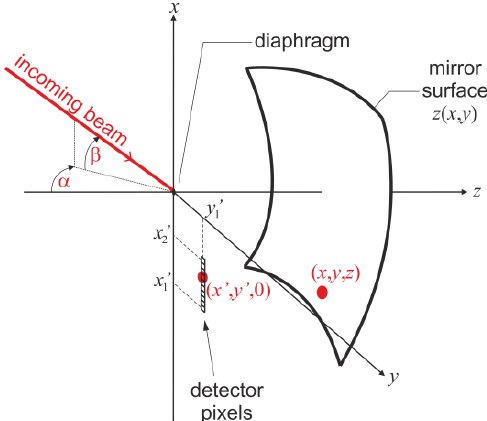
Figure 8. Geometry of the optical problem.